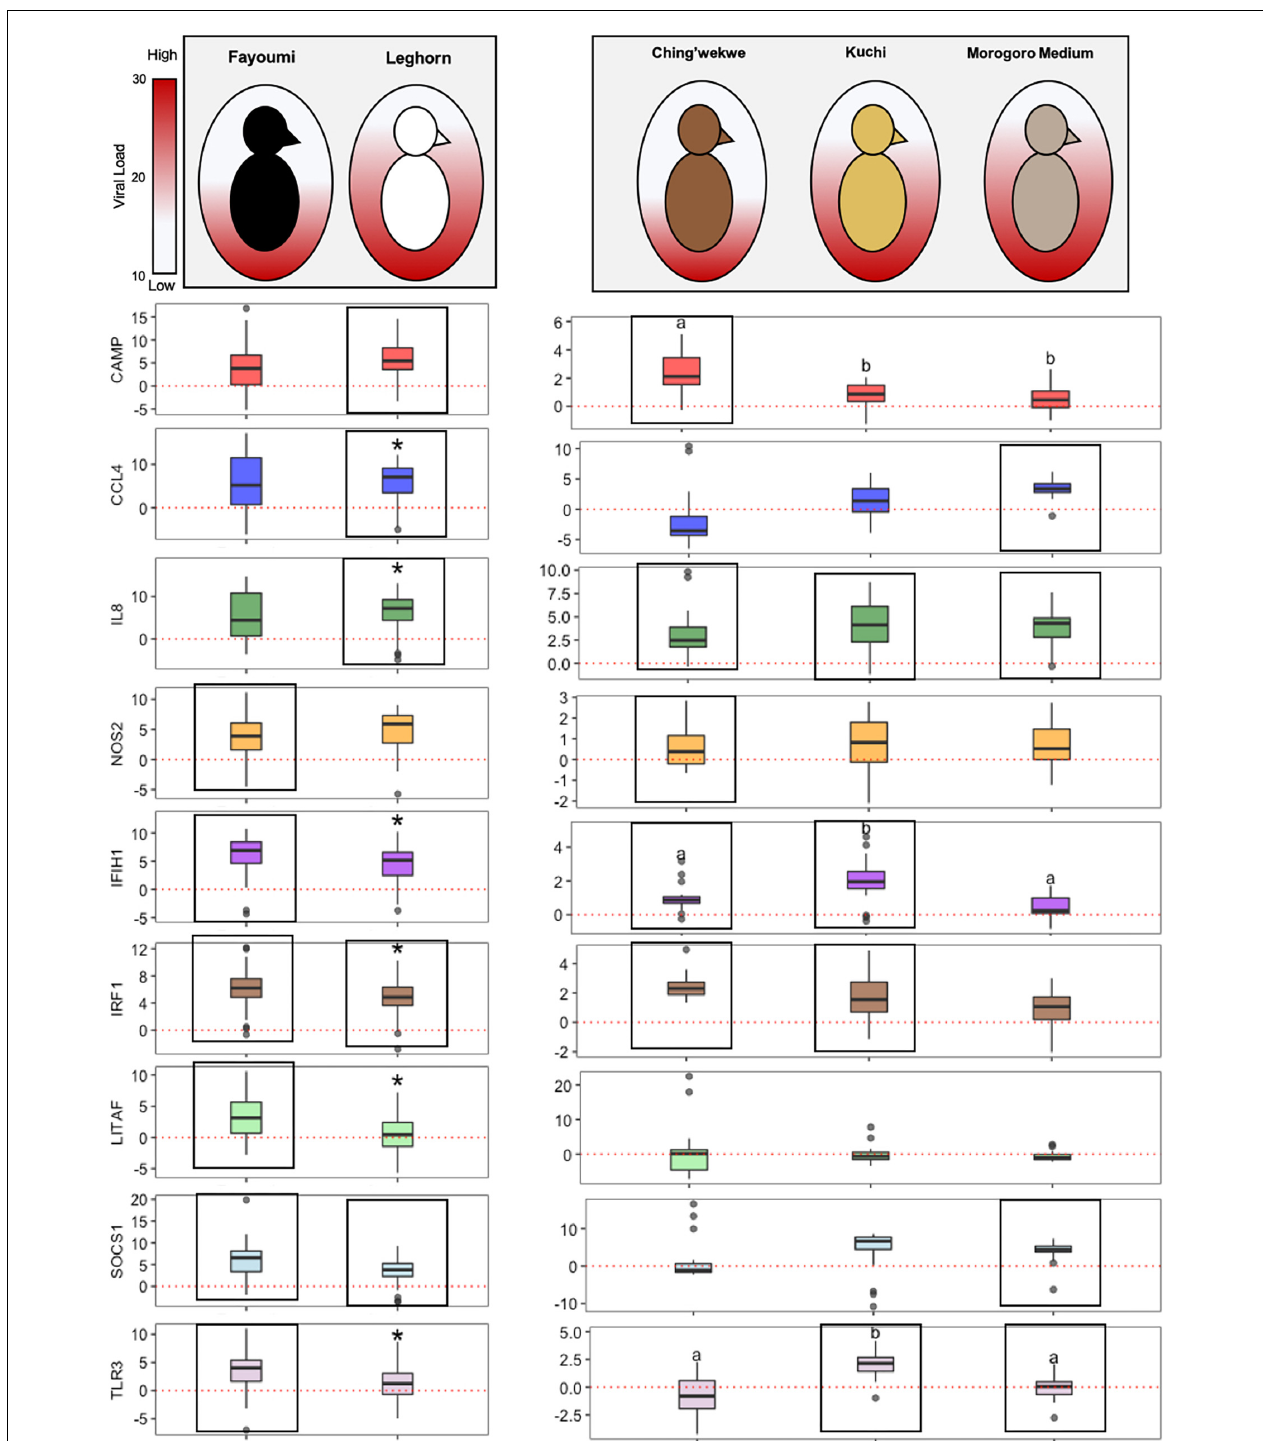
FIGURE 6 | Overall breed- and ecotype-dependent innate immune gene expression. The inbred lines, Fayoumi and Leghorn are shown on the left side of the graph and the outbred lines, Tanzanian ecotypes, are on the right. The shading in each egg represents the average viral load of each line (the more color, the higher the viral load). The boxplots show the log2(Fold Change) of each gene (middle line – median, box – Q1–Q3, whiskers – range, dots – outliers). The red line in each graph is at a y-intercept of 0, anything above the line is upregulated and anything below is downregulated. The statistical significance is represented by the ∗ in the inbred and letters in the outbred graphs ( p -value < 0.05). The boxes outline the targets that are statistically differentially expressed in the experimental group (infected) versus control group (uninfected) in each line.